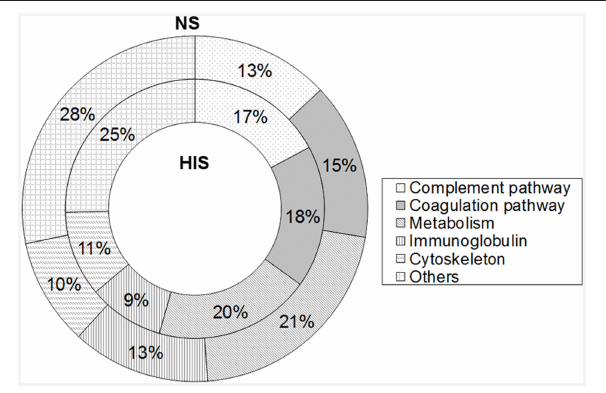
FIGURE 1 | Percentage representation of human protein groups identified in normal serum (NS) and heat inactivated serum (HIS) samples by shaving C. albicans cells. Overall, 171 proteins were identified in both conditions and were classified into the complement pathway, coagulation pathway, metabolism, immunoglobulin, cytoskeleton, and